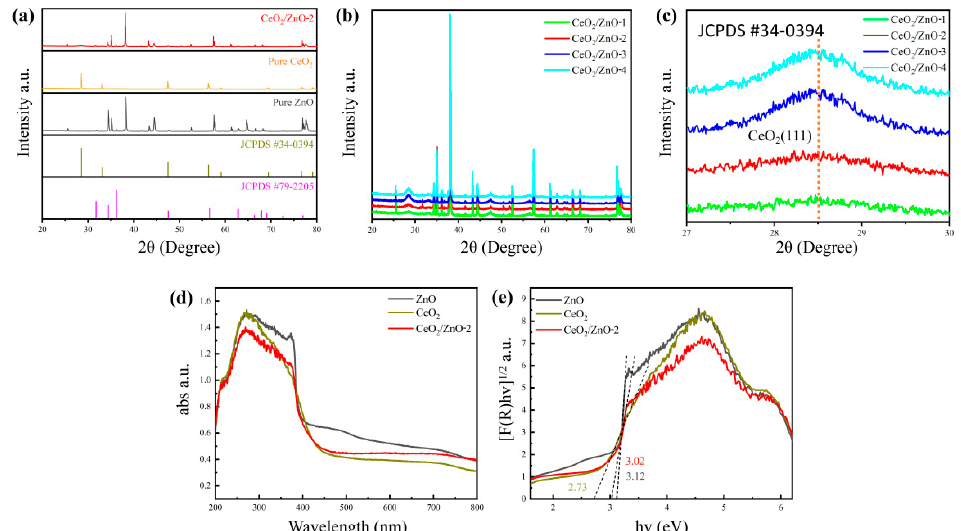
Figure 2. ( a ) XRD patterns within the range of 20 ◦ to 80 ◦ of pure ZnO, pure CeO 2 , and CeO 2 /ZnO-2. ( b ) XRD patterns within the range of 20 ◦ to 80 ◦ of CeO 2 /ZnO-1, CeO 2 /ZnO-2, CeO 2 /ZnO-3, and CeO 2 /ZnO-4. ( c ) Enlarged XRD patterns of (111) peak of CeO 2 . ( d ) UV–Vis absorption spectrum of pure ZnO, CeO 2 , and CeO 2 /ZnO-2. ( e ) The bandgap of corresponding samples.